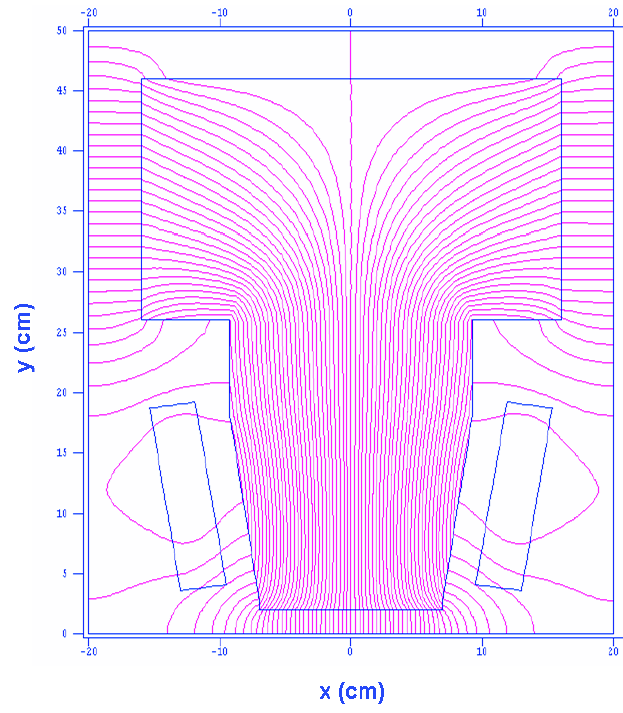
FIG. 8. (Color) Section in the x - y plane of the equivalent model of the pole of the wiggler before any